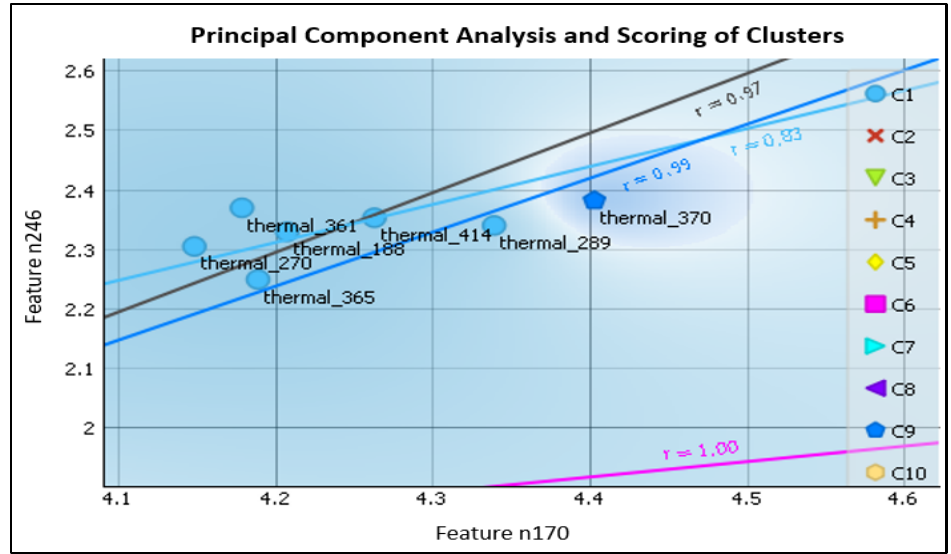
Figure 11. Features-based Principal Component Analysis and scoring of clusters. Features n170 and n246 are indicated on the X- and Y-axes, respectively. Additionally, the clusters are colour coded, and the colour of each regression line on the graph matches the colour on the cluster legend on the right.